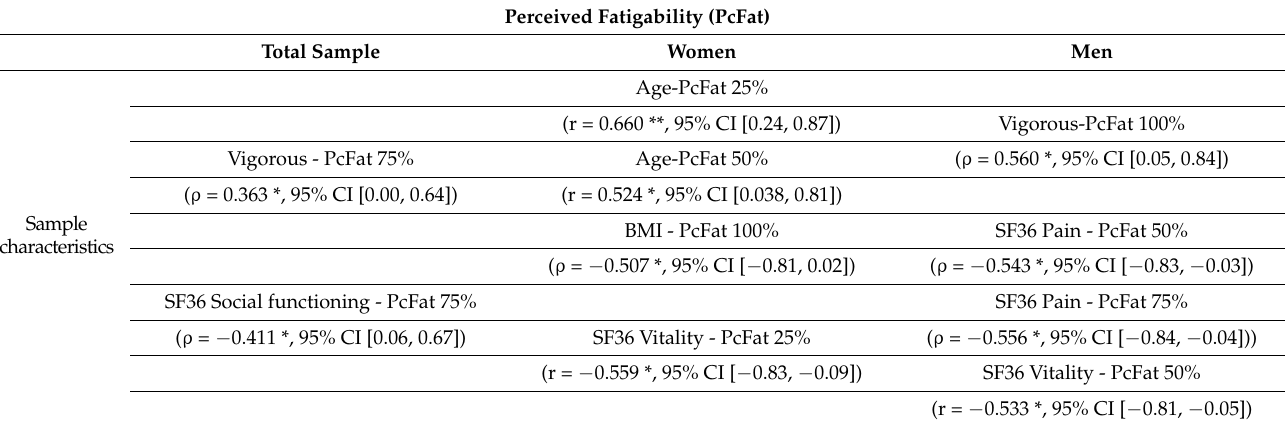
Table 6. Correlation between perceived fatigability variables and sample characteristics.